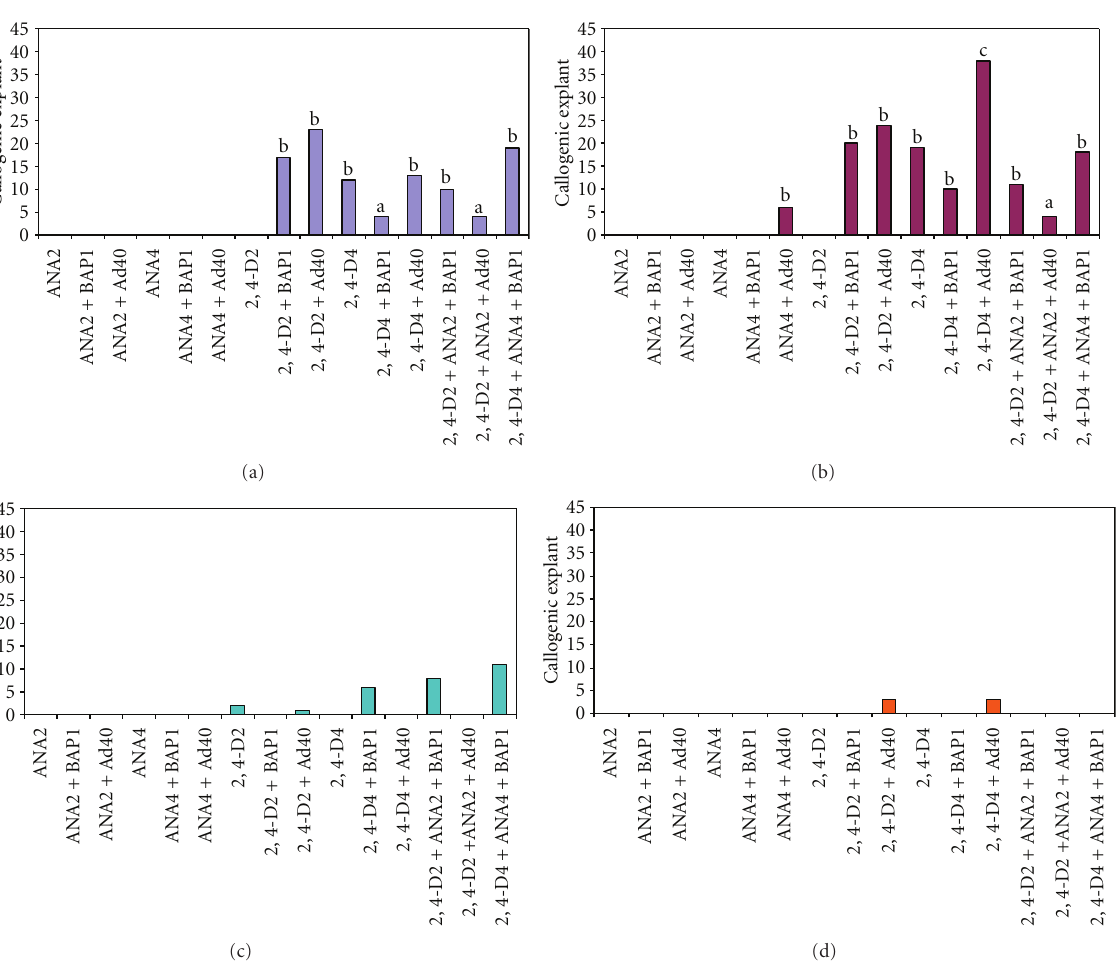
Figure 2: E ff ect of plant growth regulators (PGRs) in mg/L on the induction of callogenesis after 60 days of culture for cultivars Ahmar (a), Amsekshi (b), Tijib (c) and Amaside (d). Means were calculated from 48 explants per condition. Letters indicate significant di ff erences according to Newman and Keuls test at the level of